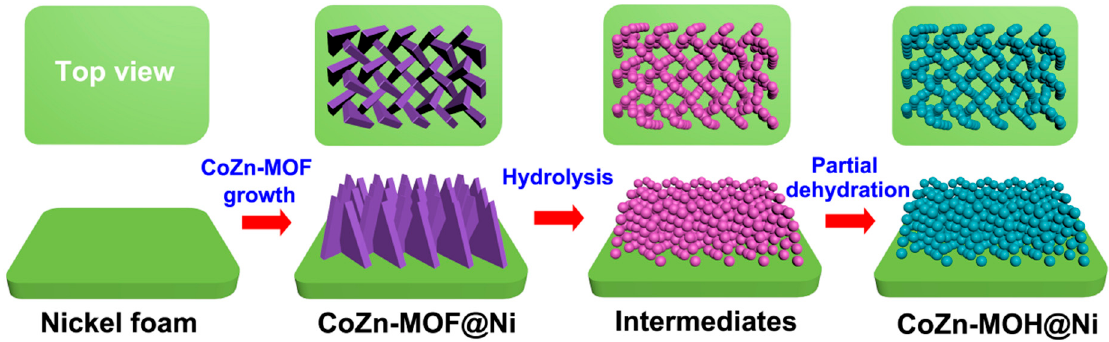
Figure 1. Scheme of the formation process of cobalt–zinc mixed oxide/hydroxide (CoZn-MOH) hierarchical porous film on Ni foam.